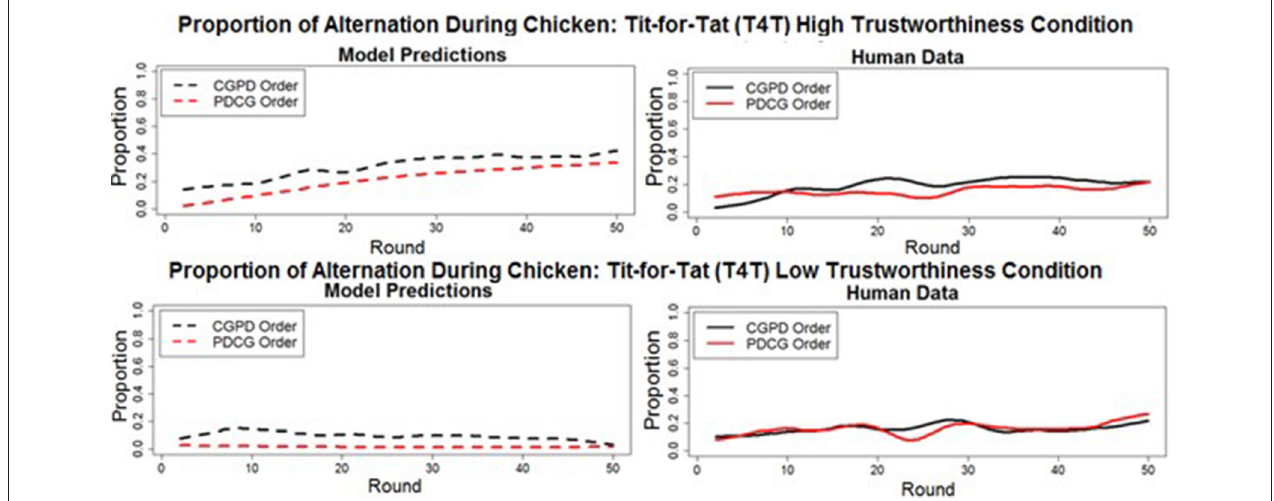
FIGURE 7 | The round-by-round proportion of alternation during Chicken Game in both the model predictions (dashed lines) and human data (solid lines), when played before (CGPD order) and after (PDCG order) the game Prisoner’s Dilemma. All of the overall round-by-round proportions were smoothed by using the loess function in R (smoothing parameter of 0.2), to remove some of the round-by-round variability.